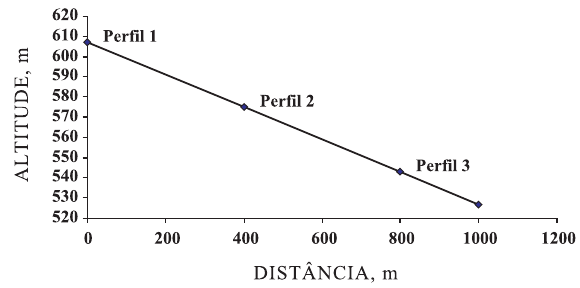
Figura 2. Situação dos perfis em relação à declividade e altitude.